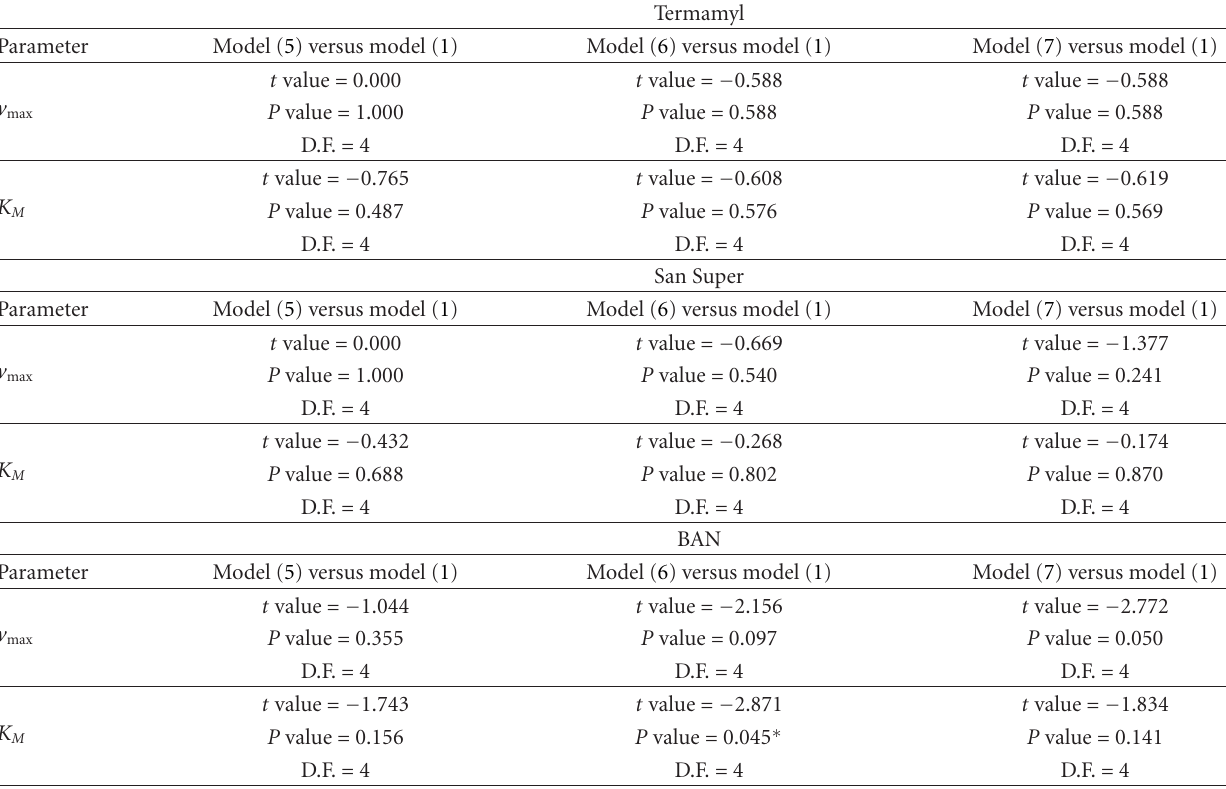
Table 3: Comparison between the values of v max and K M obtained with the overall models (5), (6), and (7) (Table 2) and those obtained with the classical Michaelis-Menten model (1) for the enzymatic reactions of the three amylolytic enzymes in unaged starch (Table 1). ∗ Significant di ff erences for P < 0 . 05. D.F.: Degrees of Freedom.